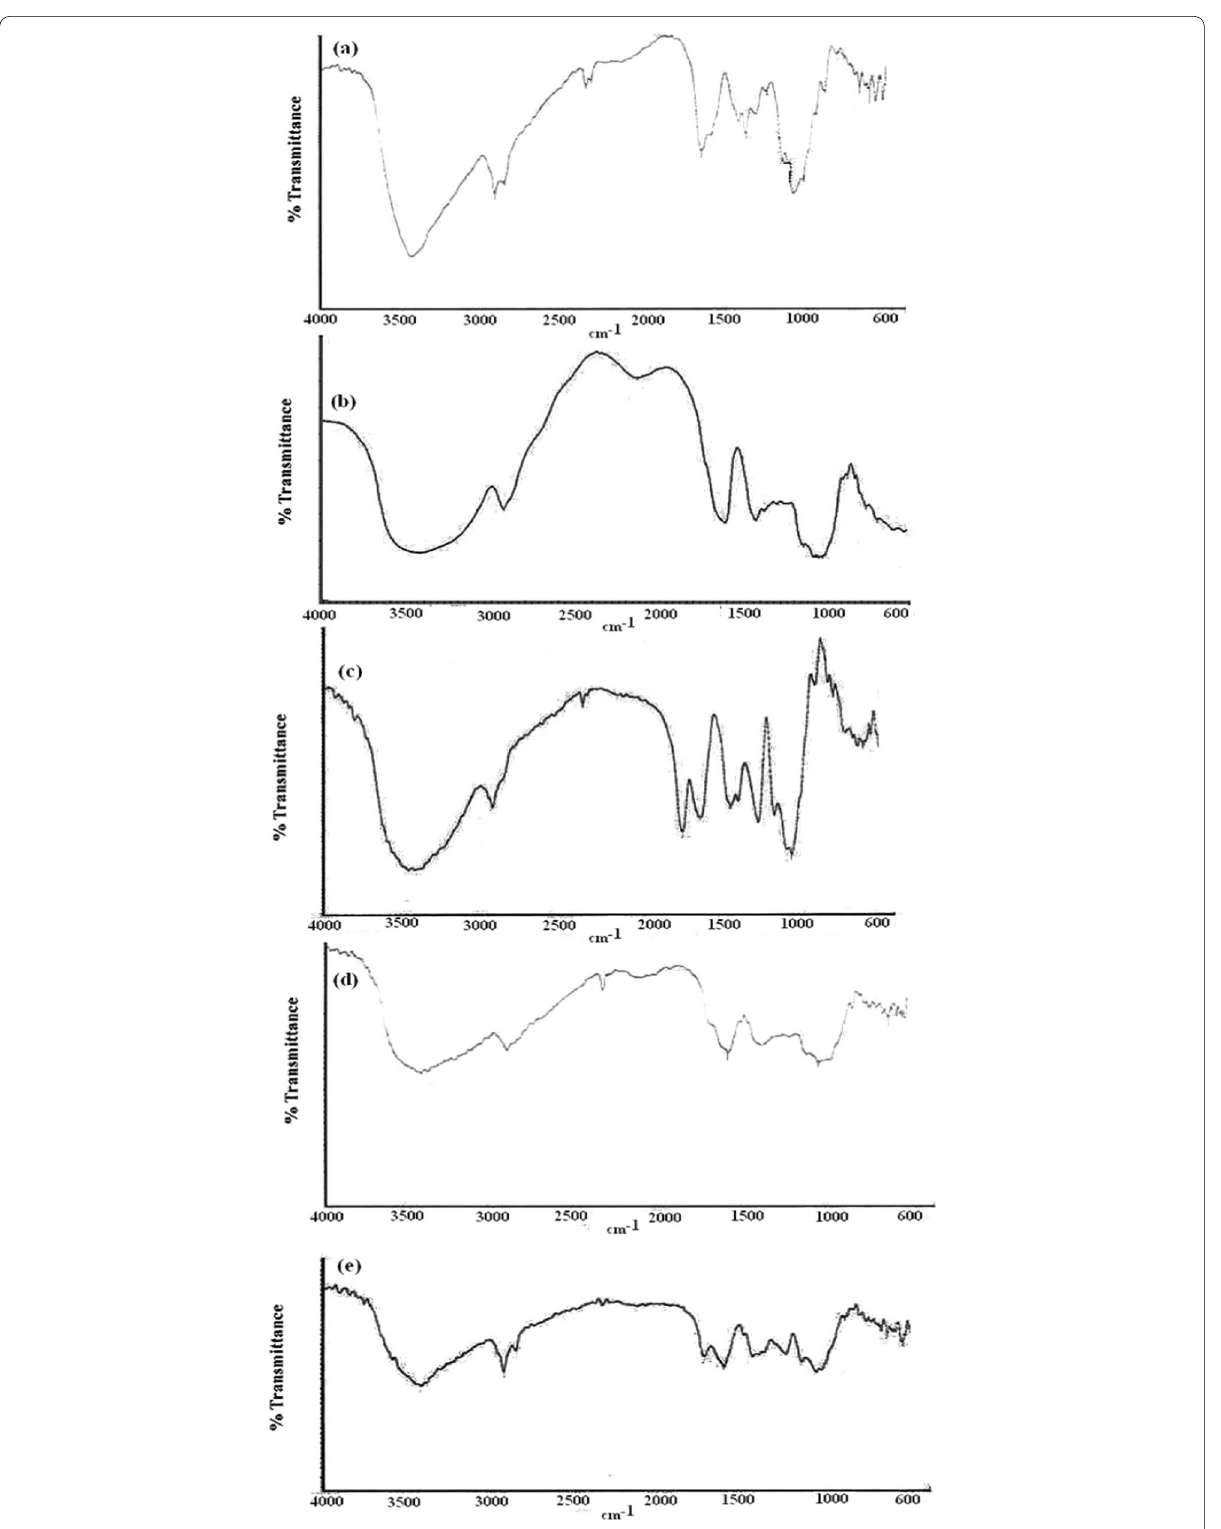
Fig. 2 FTIR spectra of Chitosan ( a ), Gum Ghatti ( b ), Gum Karaya ( c ), dried blank Chitosan–Gellan Gum–Gum Ghatti PEC beads ( d ) and dried blank chitosan–Gellan gum–gum Karaya PEC beads ( e